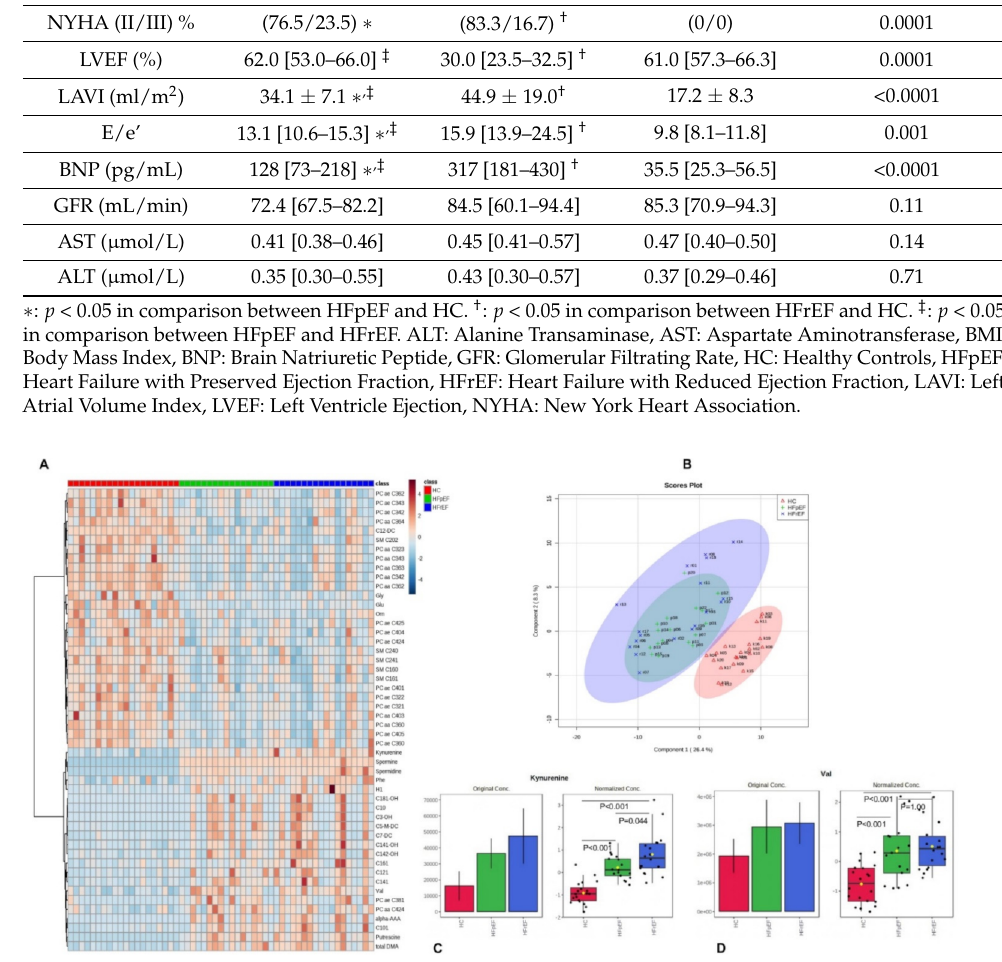
Figure 1. Metabolomic profiles of patients with HFpEF, HFrEF, and HC. ( A ) Visualization of the metabolomic profile using a heat map to show changes in top 50 metabolite concentrations among patients with HFpEF (green), HFrEF (blue), and HC (red). ( B ) Partial least squares-discriminant analysis (PLS-DA) to demonstrate the metabolomic difference among patients with HFpEF (green), HFrEF (blue), and HC (red). ( C ) Concentration of Kynurenine ( µ M) in serum in patients with HC vs. HFpEF vs. HFrEF. ( D ) Concentration of Valine ( µ M) in serum in patients with HC vs.